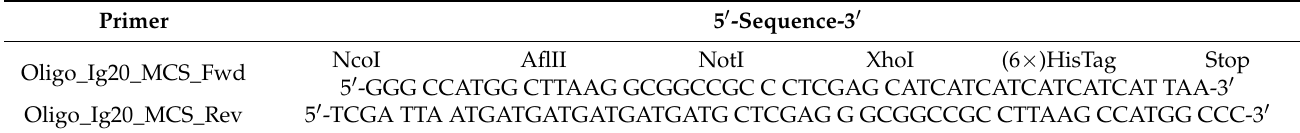
Table 2. Annealed oligo sequences for pIg20_MCS